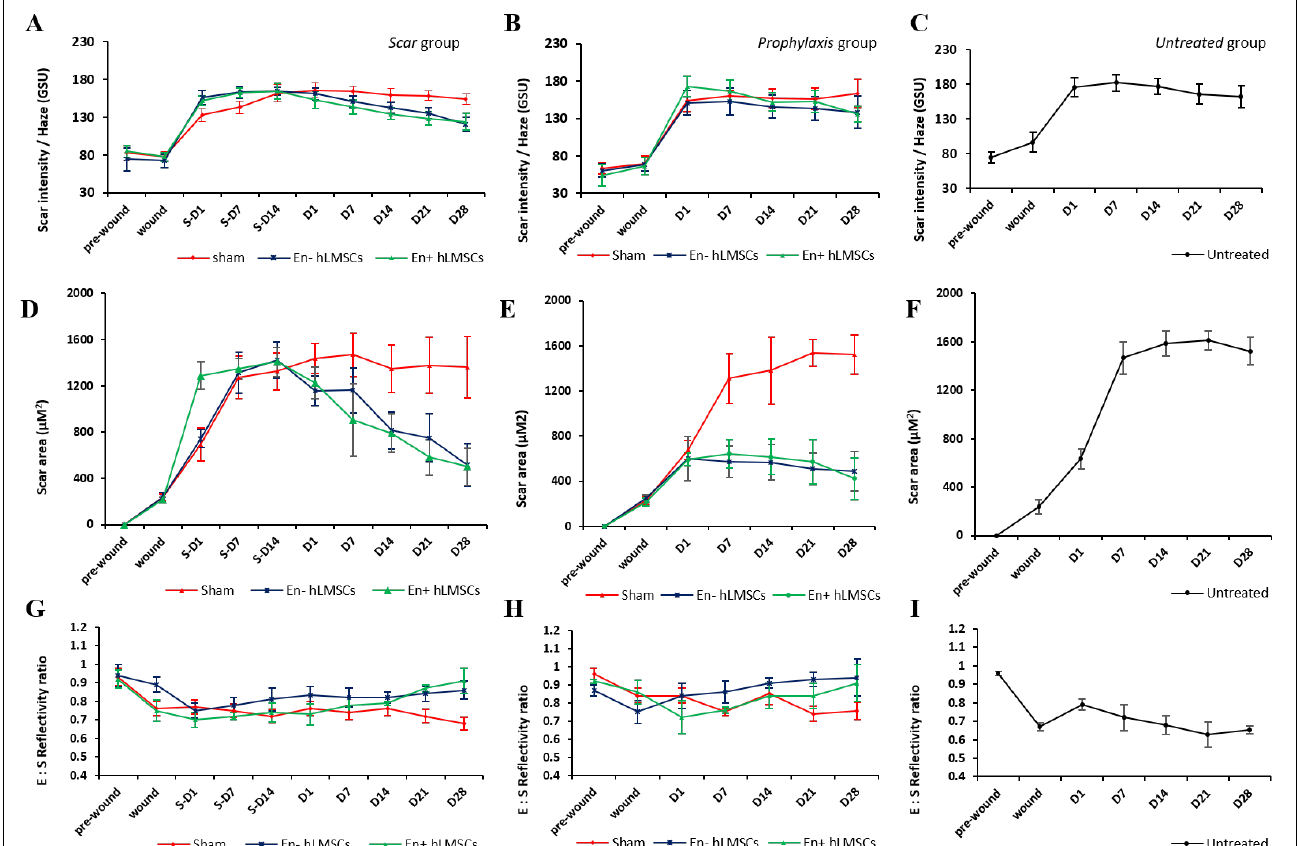
Figure 5. Changes in the corneal scar intensity, area, and reflectivity. ( A – C ) Graph plots showing the relative decrease in the corneal haze or the scar intensity of the murine eyes treated with encapsulated and non-encapsulated hLMSCs, and both. Corneas treated with vehicle alone (sham) or left untreated remained without any significant change up to the endpoint of the study. ( D – F ) Graph plots showing the reduction in the size of the corneal scars. Mice treated with hLMSCs after scar development ( D ) showed a significant decrease ( p < 0.0001, n = 8) in the scar area, relative to pre-treatment (S-D1 to S-D14), whereas the mice that received hLMSCs prophylactically did not show any significant ( p = 0.08, n = 8) increase in the scar area. ( G – I ) The reflectivity of the corneal surface normalized to the baseline readings in the eyes that received hLMSCs in both the scar ( G ) and prophylaxis ( H ) groups. The reflectivity of the stroma increased in eyes that received the sham ( G,H ) or no treatment ( I ).